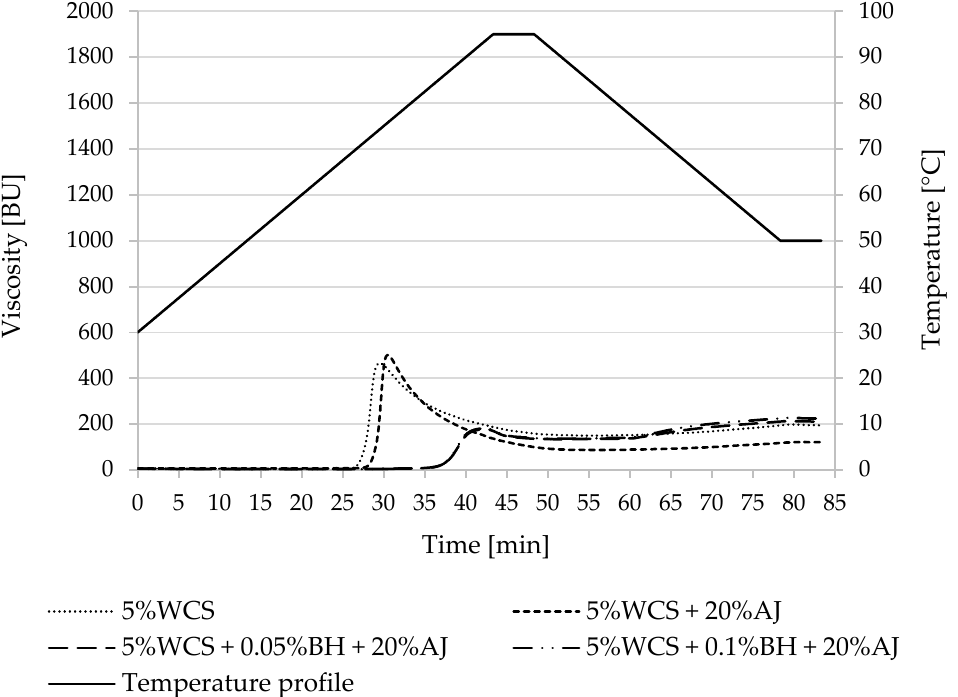
Figure 3. Pasting characteristics of 5% CS and its mixture with apple juice and buckwheat fiber. CS—corn starch, BH—buckwheat fiber, and AJ—apple juice.